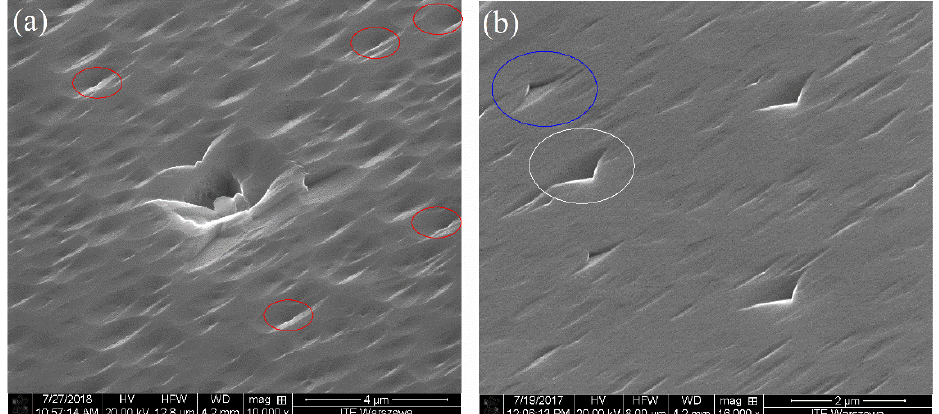
Figure 2. SEM images of #009 sample: the rectangular and triangular (marked) etch pits originating from the stacking faults and the dislocations, respectively ( a ), and two types of triangular etch pits originating from 60° misfit dislocations of alternating orientations ( b ).